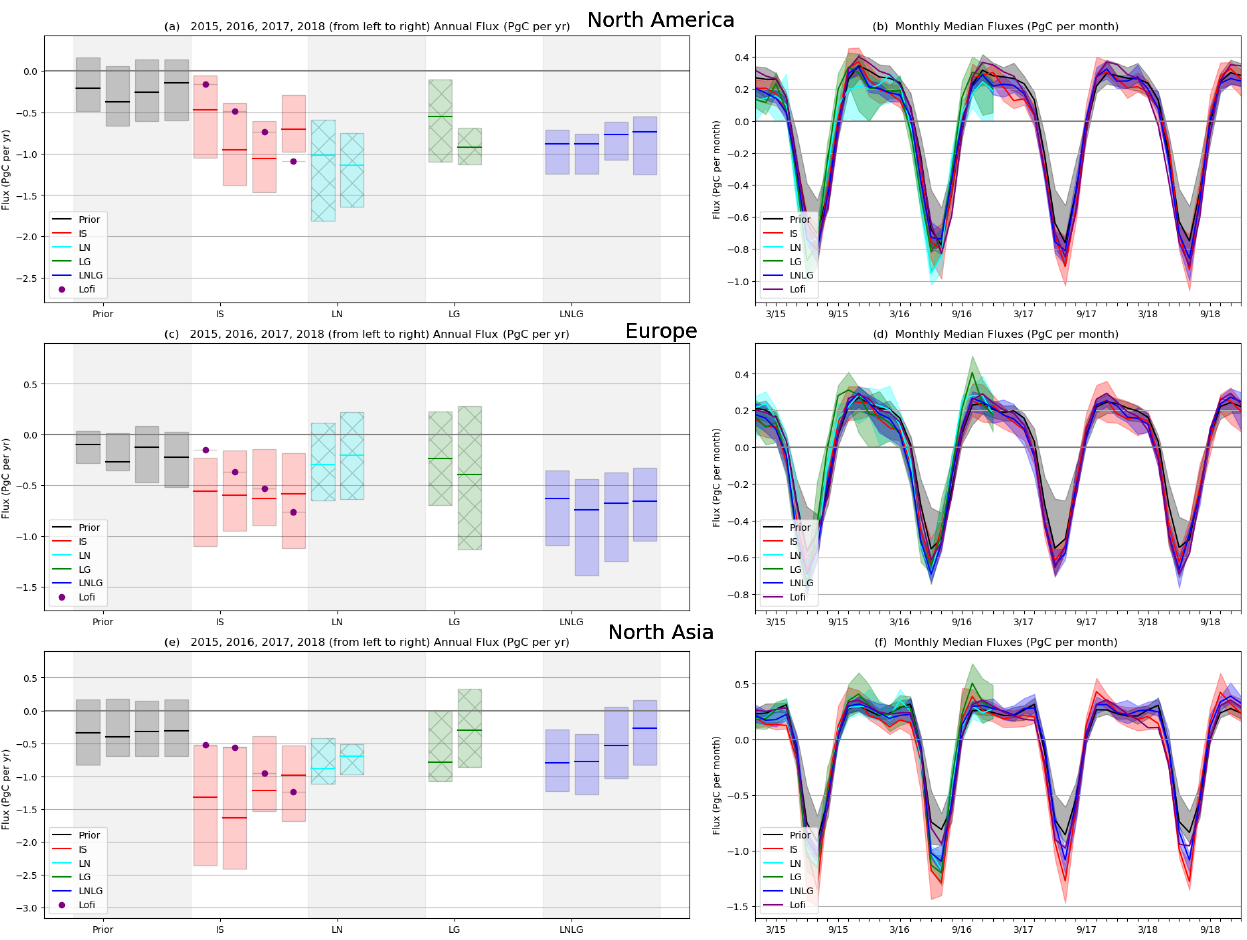
Figure 8. Same as Fig. 6 but for the northern extra-tropics regions: North America (a, b) , Europe (c, d) , and northern Asia (e, f)